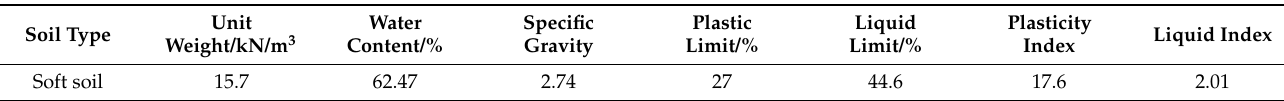
Table 1. Physical and mechanical parameters of soil.